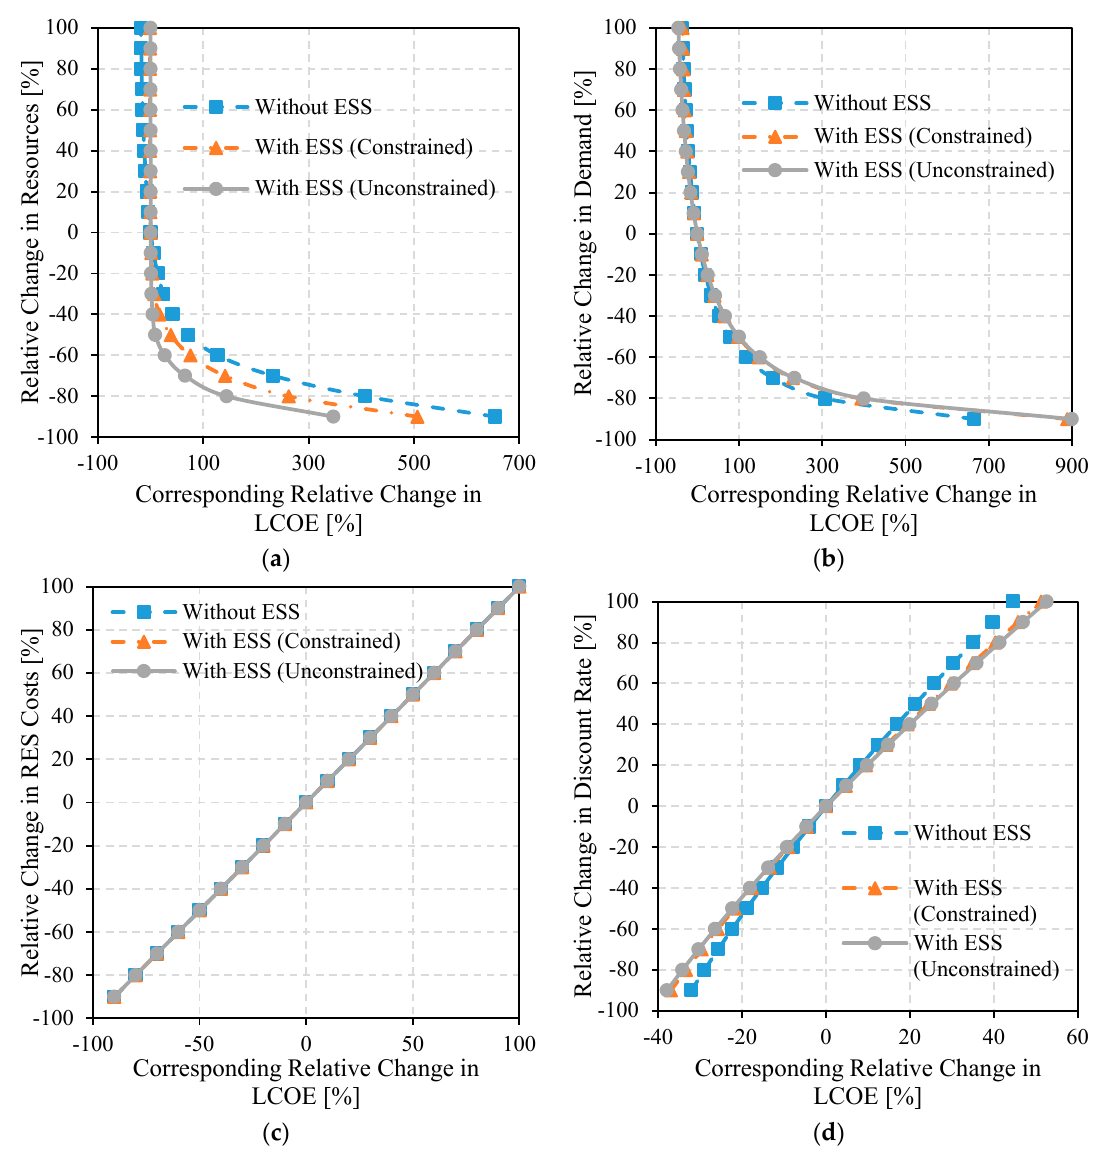
Figure 10. The sensitivity of the LCOE to the variations in the: ( a ) Solar and wind resources, ( b ) demand, ( c ) RES costs, and ( d ) annual discount rate.